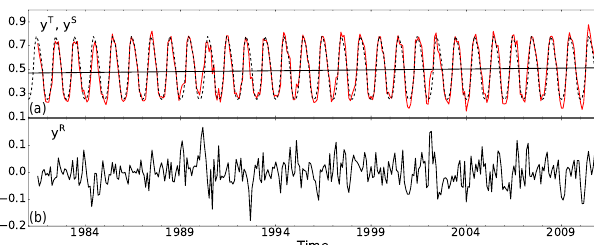
Figure 2. The three components of the NDVI time series decom- position of a specific pixel of the Northern Hemisphere (lat: 53.5 ◦ , long: 26.5 ◦ ). On top are the linear trend (black continuous line) and the seasonal cycle (dashed black line) fitted on the raw data (red). On the bottom are the remaining anomalies; see text for